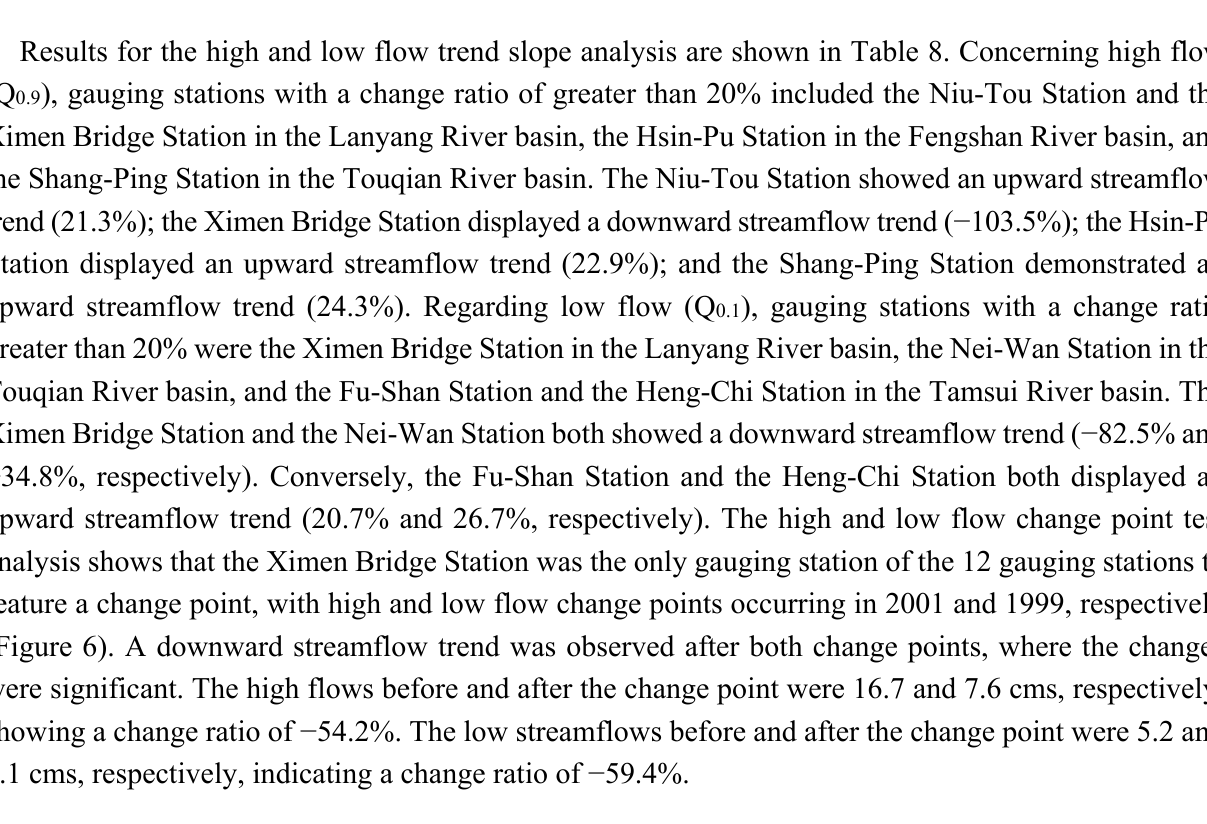
Figure 5. Maps showing spatial variation in trends in high and low flows: ( a ) high flow; ( b ) low